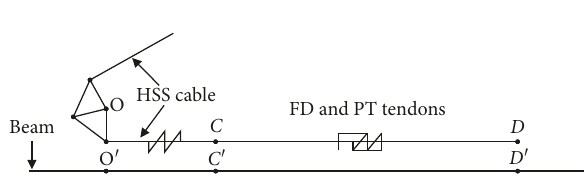
Figure 8: Simulation of the pulley.